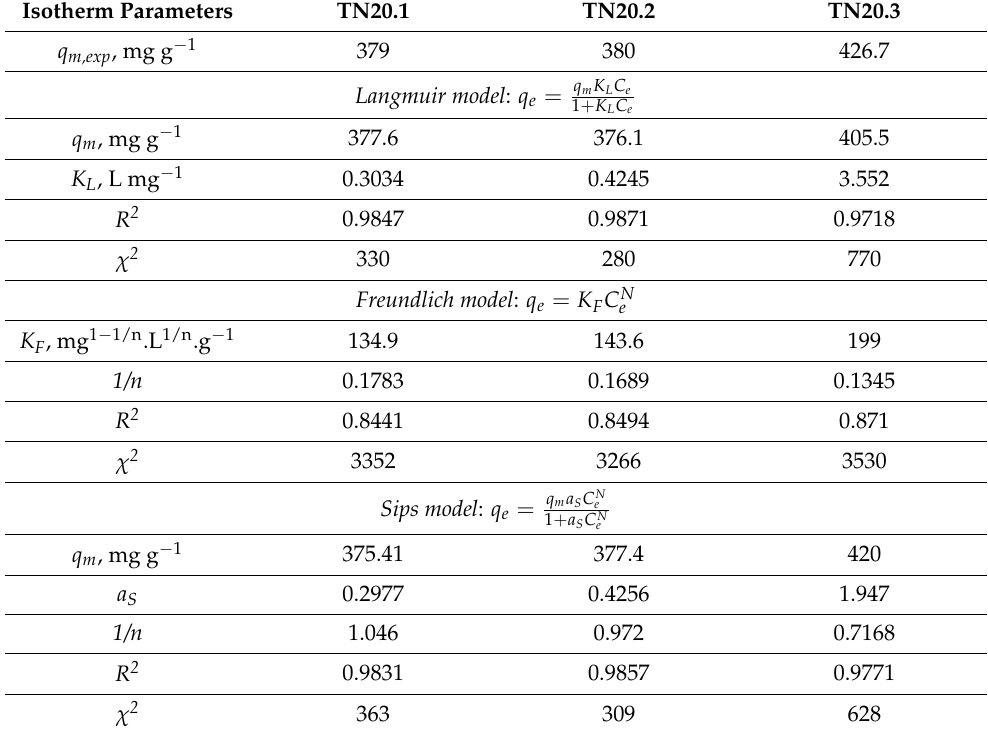
Table 5. Isotherm parameters for the sorption of Cr 2 O 72 − anions onto TN composite cryogels derived from